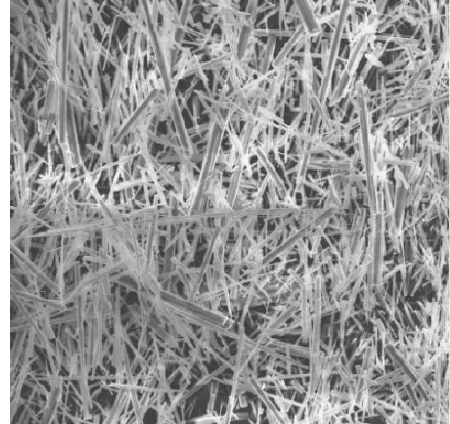
Figure 1. Calcium sulfate whisker.